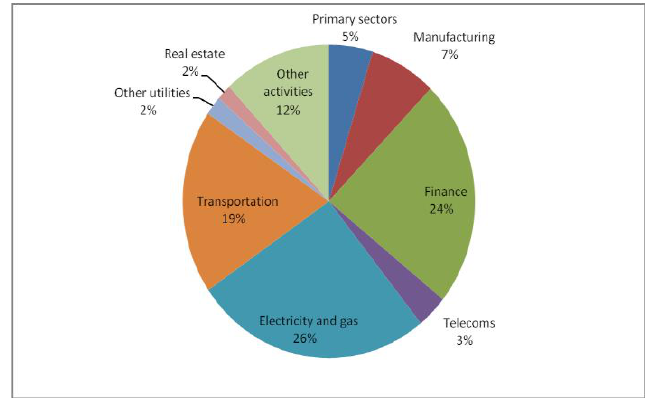
Fig. 1. Sectoral distribution of SOE sector, by company value (total OECD) (Christiansen,